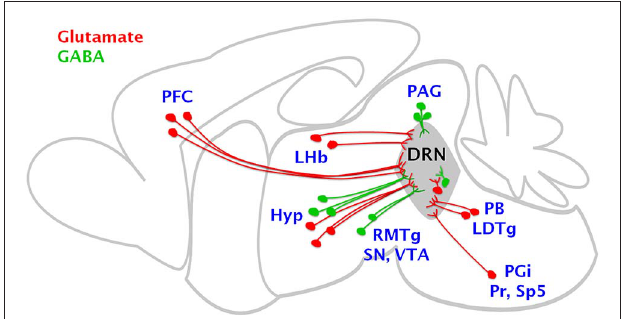
FIGURE 1 | Brain regions sending glutamate and GABA axon projections to the DRN . The cartoon summarizes the main sources of glutamate excitatory and GABAergic inhibitory inputs to the DRN. Glutamate cells (in red) are mainly located in the prefrontal cortex (PFC), lateral habenula (LHb), hypothalamus (Hyp), parabrachial nucleus (PB), laterodorsal tegmental nucleus (LDTg), paragigantocellular nucleus (PGi), prepositus hypoglossal nucleus (Pr) as well as the spinal trigeminal nucleus (Sp5), as well as in local sources including the DRN. GABAergic cells (in green) sending projections to the DRN are located mainly in the hypothalamus, substantia nigra (SN), ventral tegmental area (VTA), rostromedial tegmental nucleus (RMTg) and locally within the periaqueductal gray (PAG) and DRN.